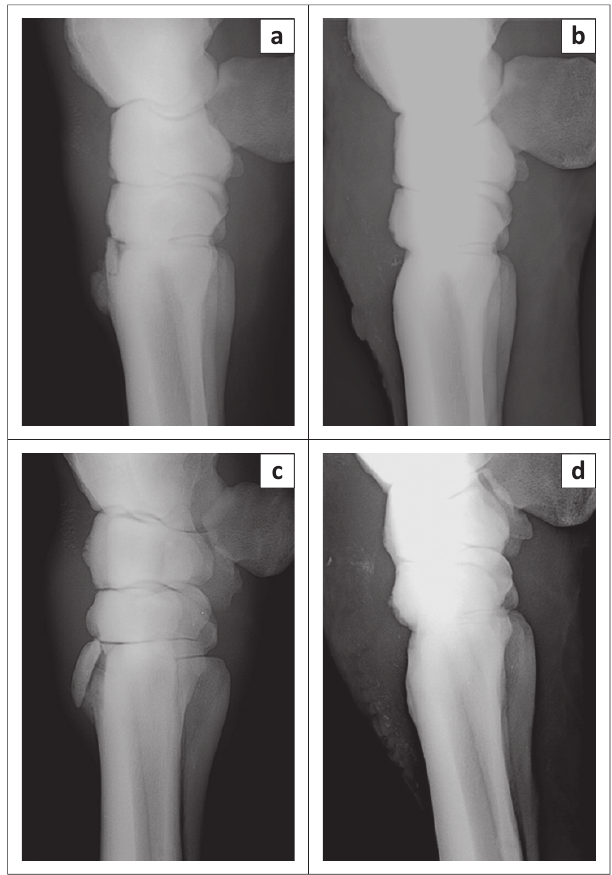
FIGURE 1: Computed radiographs of a 3-year-old Thoroughbred colt trained for racing. The left side depicts the left (a) and right (c) carpi, prior to surgery for removal of distinct, large, articular fatigue fractures at the proximal dorsal third metacarpal bone. The right side depicts the left (b) and the right (d) carpi after surgical removal of the